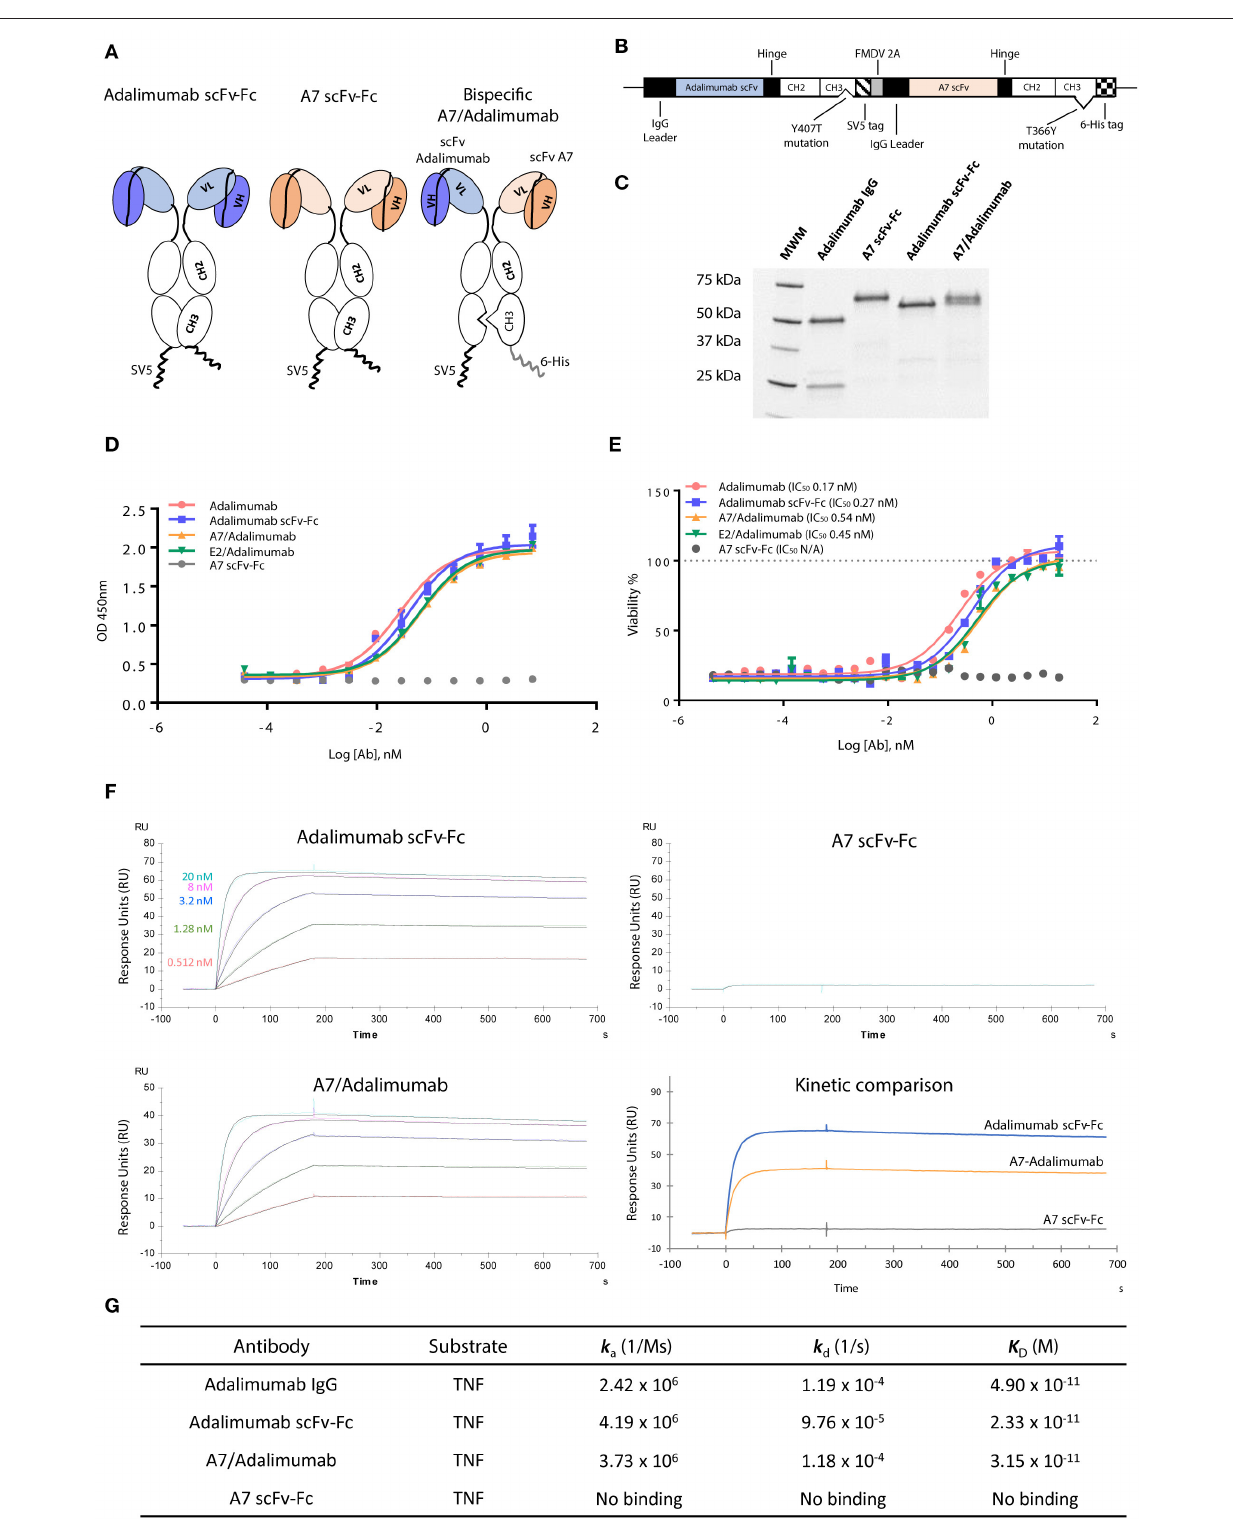
FIGURE 1 | Characterization of scFv-Fc antibody constructs. (A) ScFv of interest was cloned in fusion with the immunoglobulin (IgG) Fc region as single-chain variable fragment (scFv)-Fc construct. Bispecific scFv-Fc antibody carried the A7 scFv-Fc fused to the Fc chain containing the “hole” T366Y mutation while the adalimumab